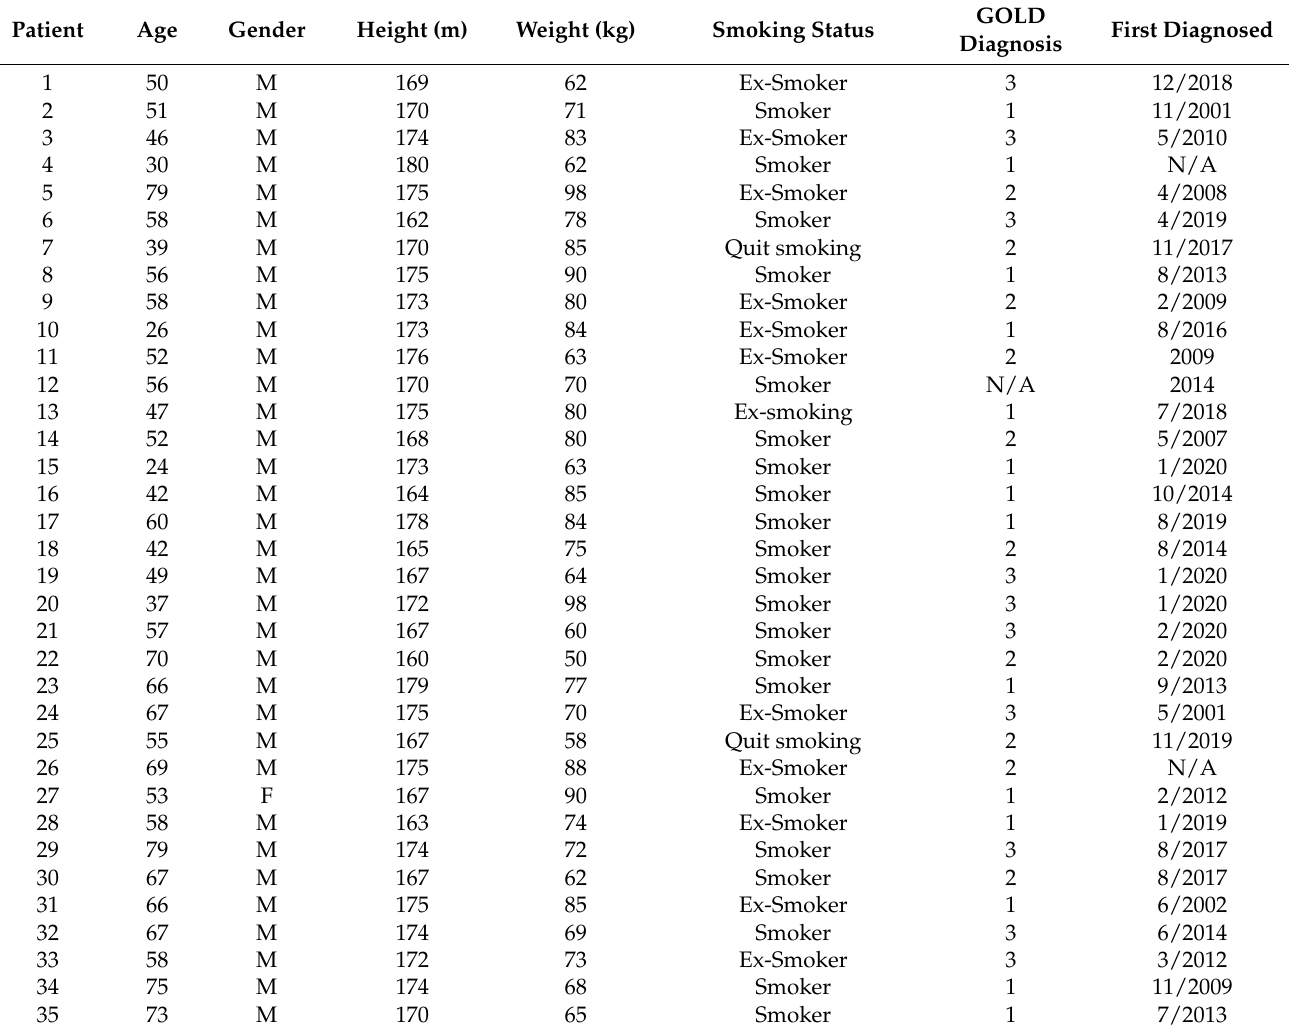
Table A1. Summary of patients’ information